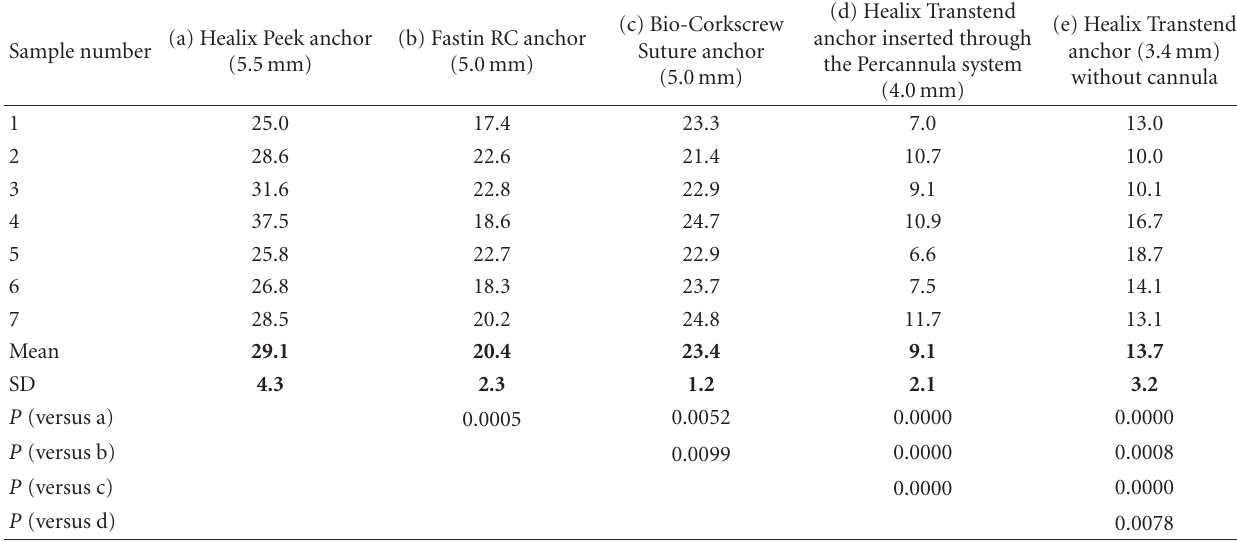
Table 1: Areas of tendon damage caused by